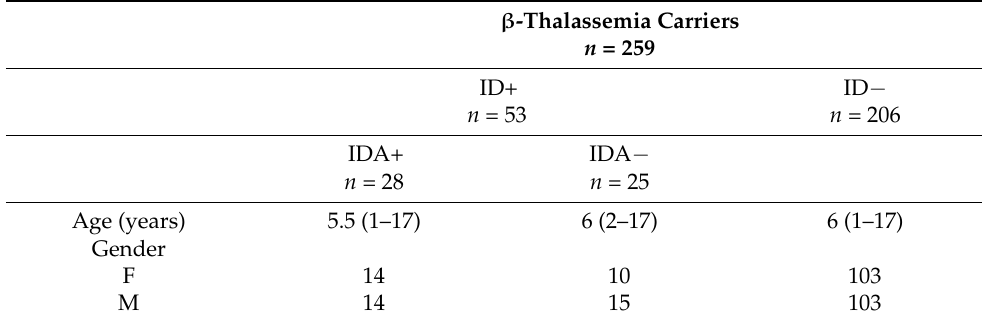
Table 1. Clinical characteristics of the